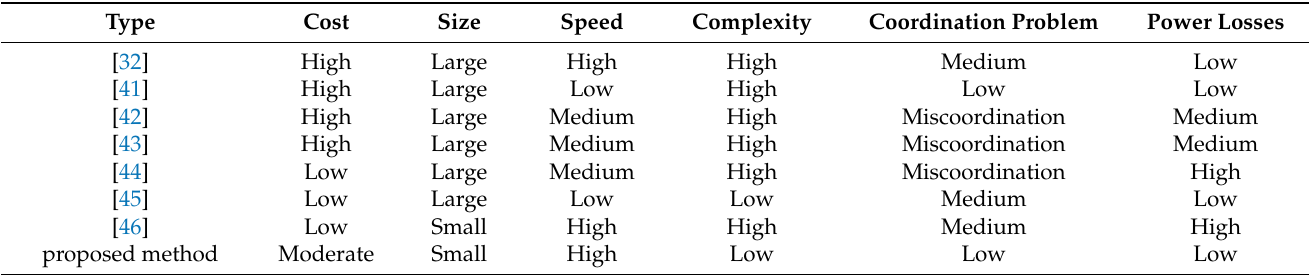
Table 4. Comparison of the proposed DC FCL with other existing methods.